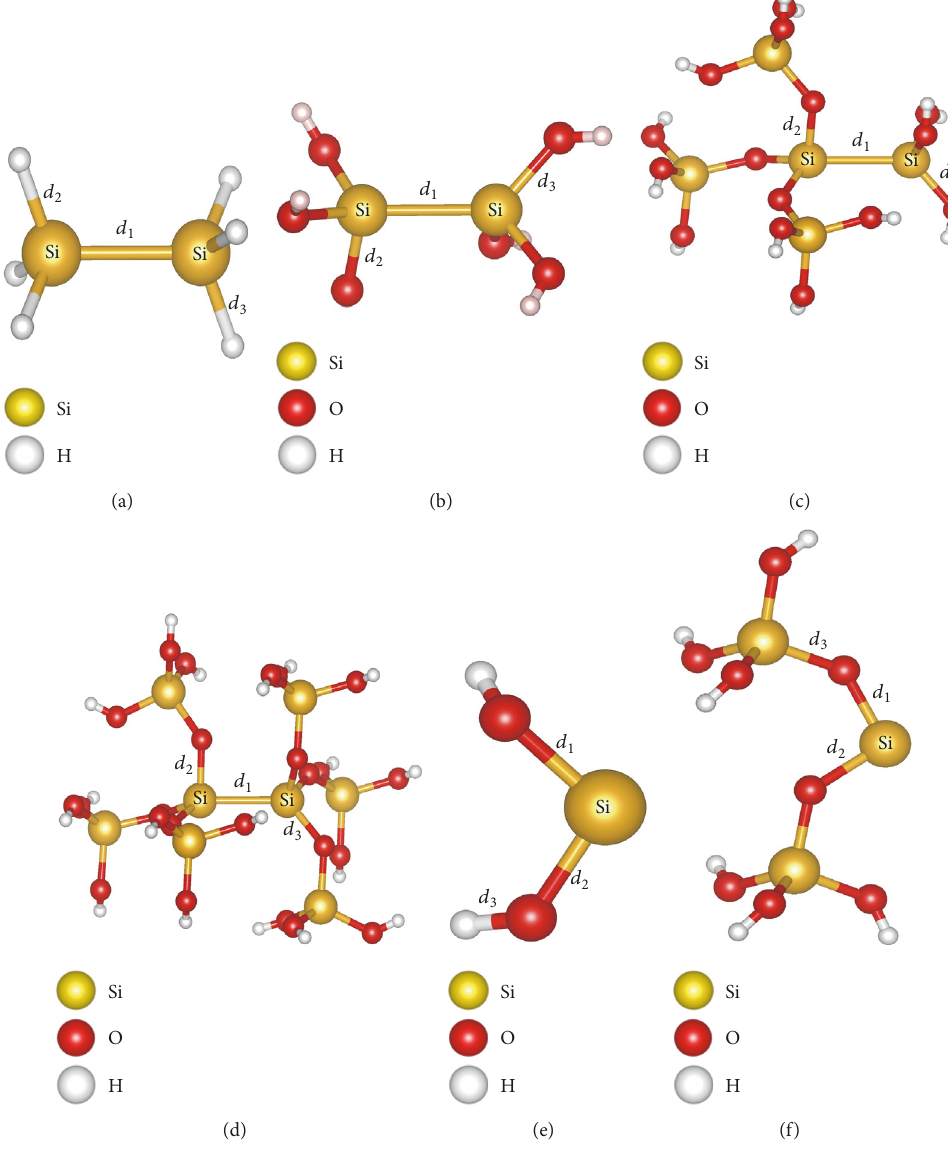
Figure 1: Illustrations of each of the six clusters used for S 0 → S 1 transition energy for 𝛼 -quartz cluster configurations with oxygen-deficiency centers. (a) Si 2 H 6 with ODC(I), (b) Si 2 O 6 H 6 with ODC(I), (c) Si 5 O 15 H 12 with ODC(I), (d) Si 8 O 24 H 18 with ODC(I), (e) SiO 2 H 2 with ODC(II), and (f) Si 3 O 8 H 6 with ODC(II). We use hydrogen atoms to passivate the oxygen atoms which terminate our cluster